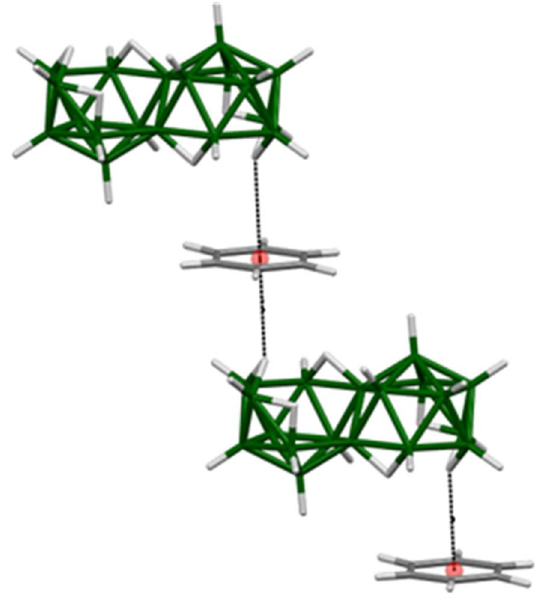
Figure 3. The crystal structure of the anti -B 18 H 22 —benzene solvate [28] with anti -B 18 H 22 ···benzene stacks arising from interaction between the H(8,9) bridging hydrogen atom and the π-cloud of the benzene ring.